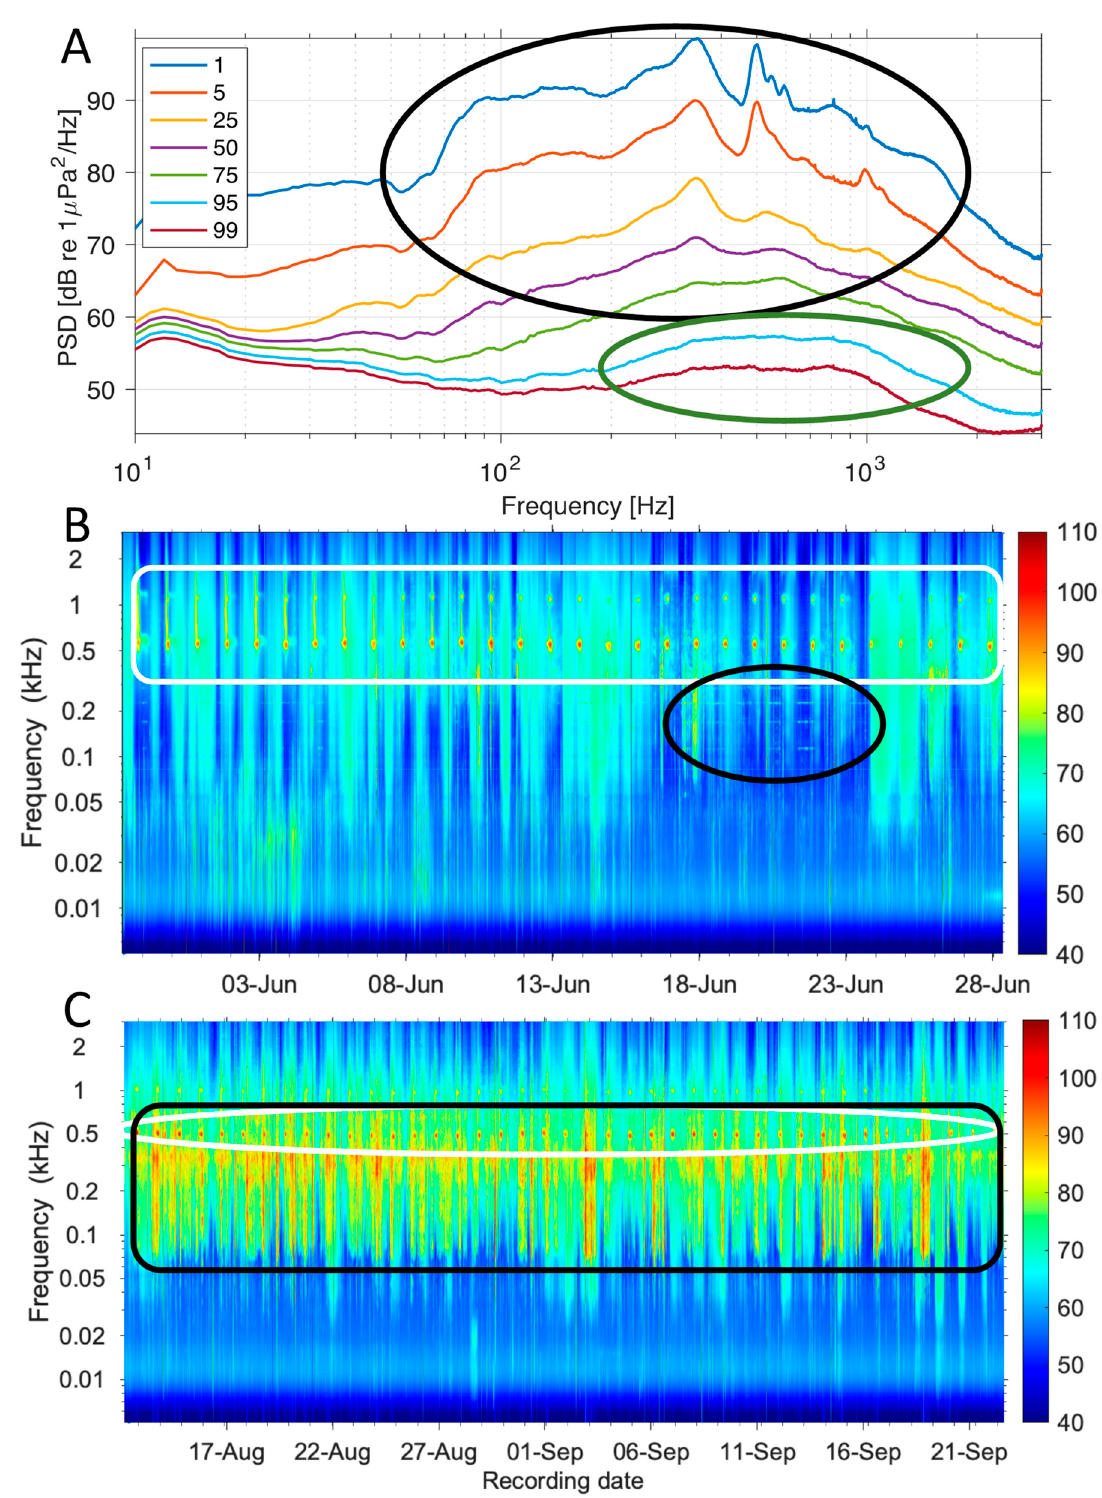
Figure 10. Winter soundscape at site 12. ( A ) Power spectral density percentiles showing domination by humpback whales from late June and fishes throughout. The curves follow the shape of the biological spectra 75% of the time (within black ellipse). The characteristic shape of wind is only seen in the absence of whales (lowest two percentiles within green ellipse); ( B ) LTSA of an evening fish chorus (within white box). A distant dwarf minke whale chorus (thin horizontal lines inside black ellipse) occurred in June–July. ( C ) LTSA showing humpback whales (within black box) and fish (within white ellipse).